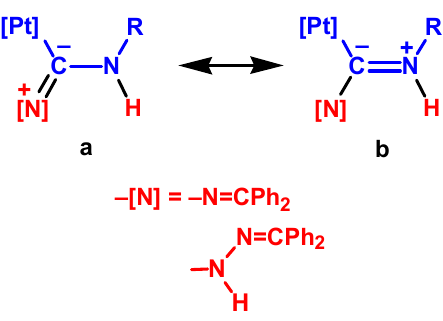
Figure 6. Resonance structures of the nucleophilic addition products.